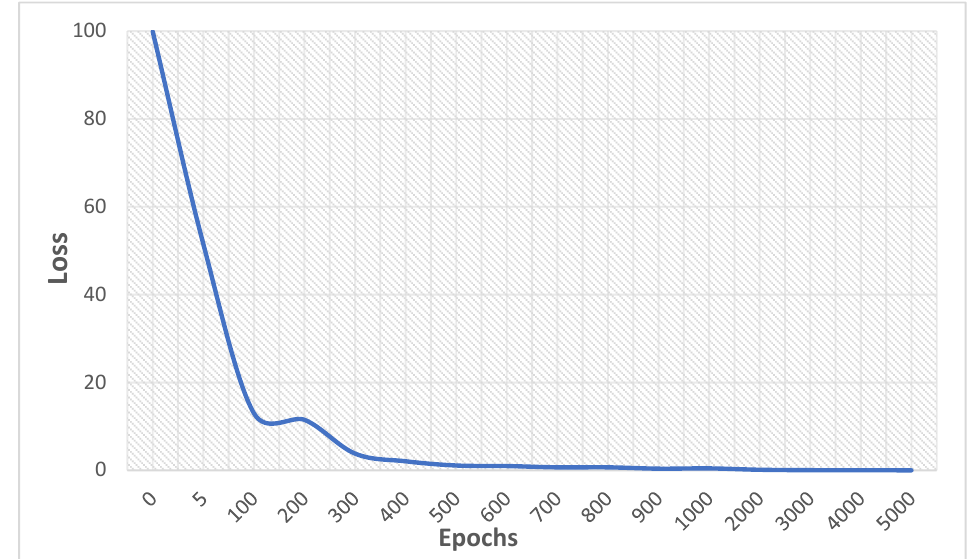
Figure 8. The Loss of Training Data.